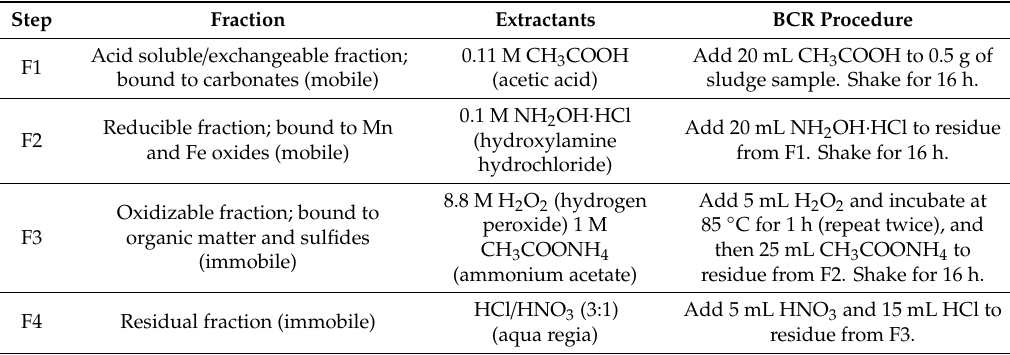
Table 2. The Community Bureau of Reference (BCR) sequential extraction procedure